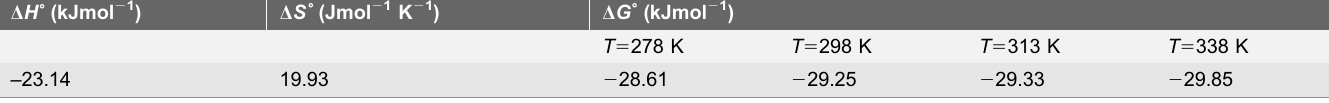
Table 2. Calculated thermodynamic parameters of 5.0 mgL 2 1 Co(II) adsorption on 25.0 mg Ag 2 O 3 -ZnO NCs ( N 5 3). D H ˚ (kJmol 2 1